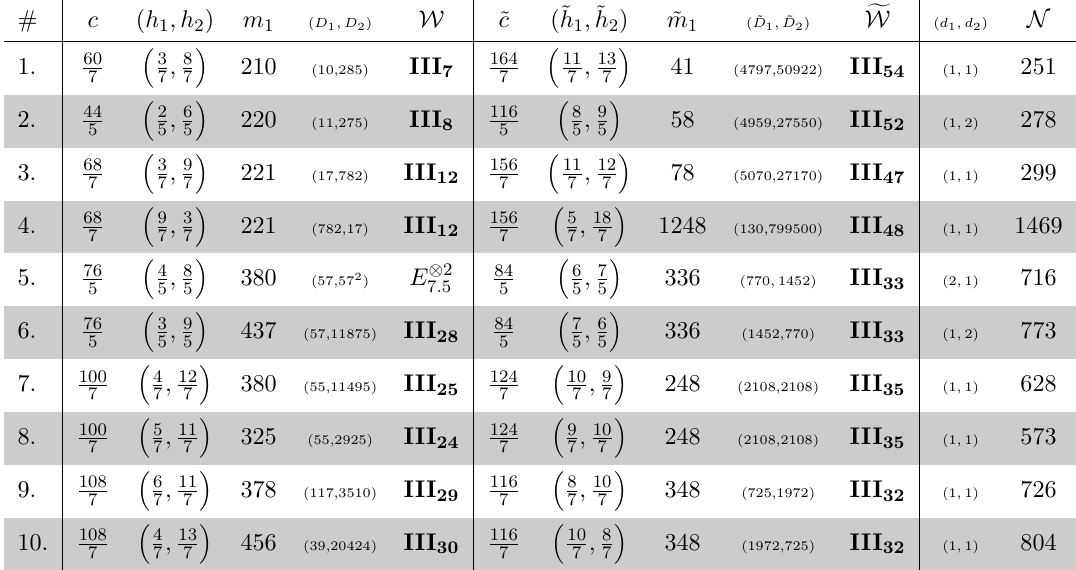
Table 15. IVOA-type pairings, c H = 32 with ( n 1 , n 2 ) = (2 , 3) . The integer N in the last column gives the total number of dimension-1 states in the meromorphic character j 2